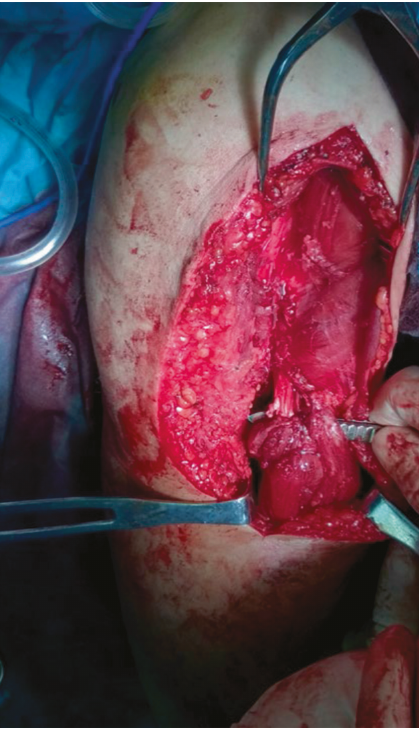
Figure 3: Intraoperative photograph showing the intramuscular biceps tear (yellow arrows).